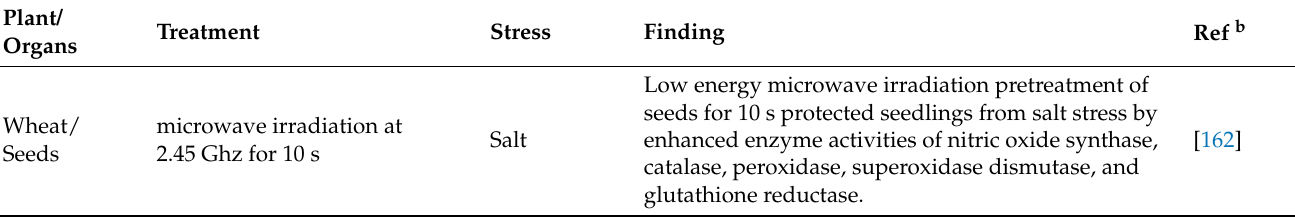
Table 5. The effects on abiotic stress tolerance of the different irradiation sources. Plant/